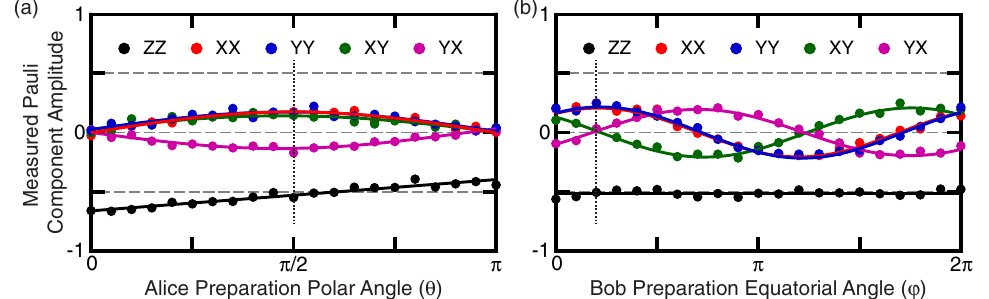
FIG. 3. Two-qubit remote entanglement. Measured amplitudes of the relevant two-qubit Pauli vector components as a function of qubit preparation. After the remote entanglement protocol described in Fig. 1(b), joint tomography was performed on the qubits conditioned ffiffiffi p 2 on the detector reporting a click for each round. (a) With Bob always initialized in ð 1 = Þðj g i þ j e iÞ , Alice was prepared in the variable state cos ð θ = 2 Þj g i þ sin ð θ = 2 Þj e i . Data (points) and fits (lines) confirm that entanglement is maximized when θ ¼ π = 2 (dotted line). ffiffiffi ffiffiffi p p 2 2 (b) With Alice always initialized in ð 1 = Þðj g i þ j e iÞ , Bob was prepared in the variable state ð 1 = Þðj g i þ e i ϕ j e iÞ . The components of the Pauli vector oscillate with ϕ sinusoidally, as expected. The complete density matrix for ϕ given by the dotted line is shown in Fig. 4 (left) in the Pauli basis.